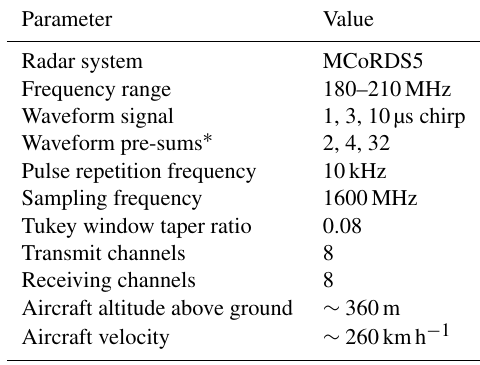
Table 1. Acquisition parameters of the EGRIP-NOR-2018 radar